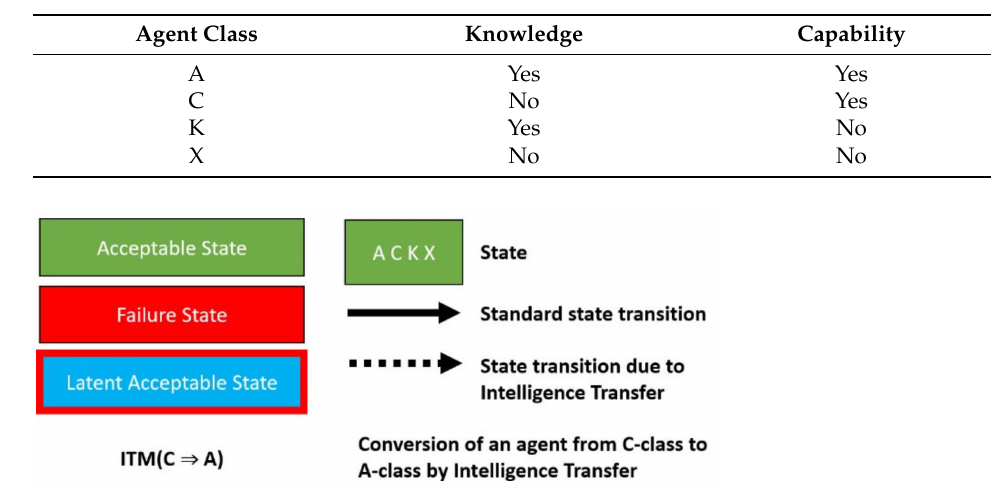
Table 3. Definitions of agent classes in the Static Task-Based Redundancy Model (Static TBRM).